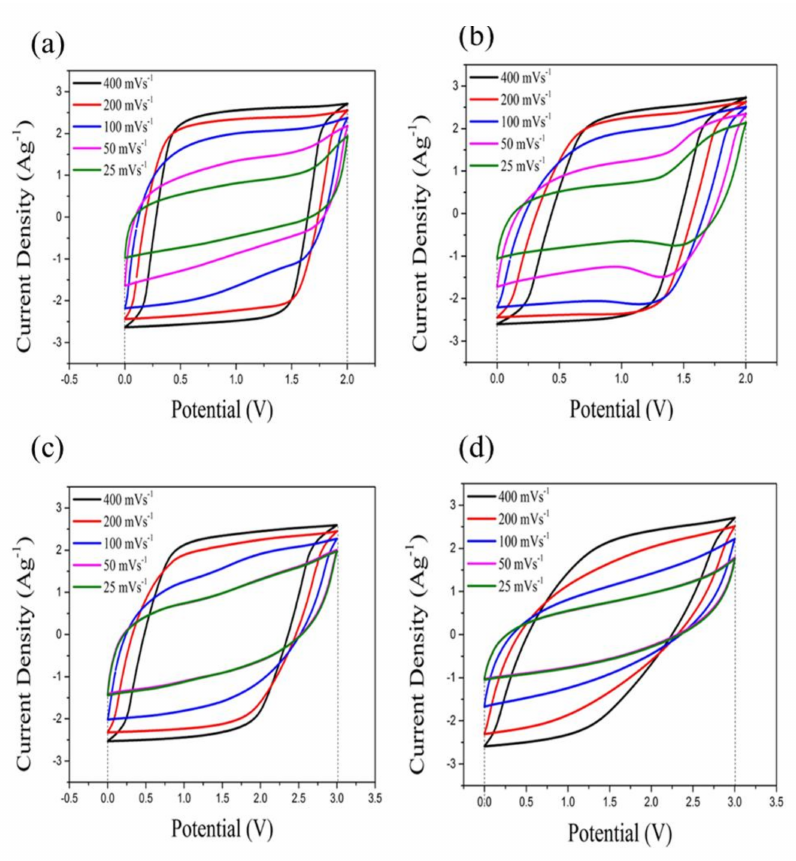
Figure 5. Cyclic voltammograms (CVs) of ( a ) MBIB; ( b ) PIL-M-(Br); ( c ) MBIT; and ( d ) PIL-M-(TFSI)-based supercapacitors at different scan rates.